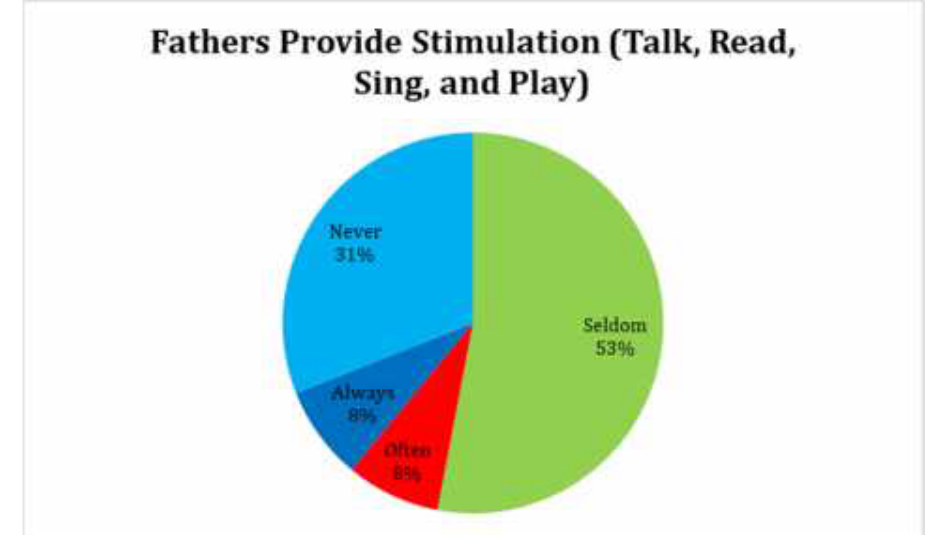
Fig 5 Fathers Provide Stimulation (Talk, Read, Sing and